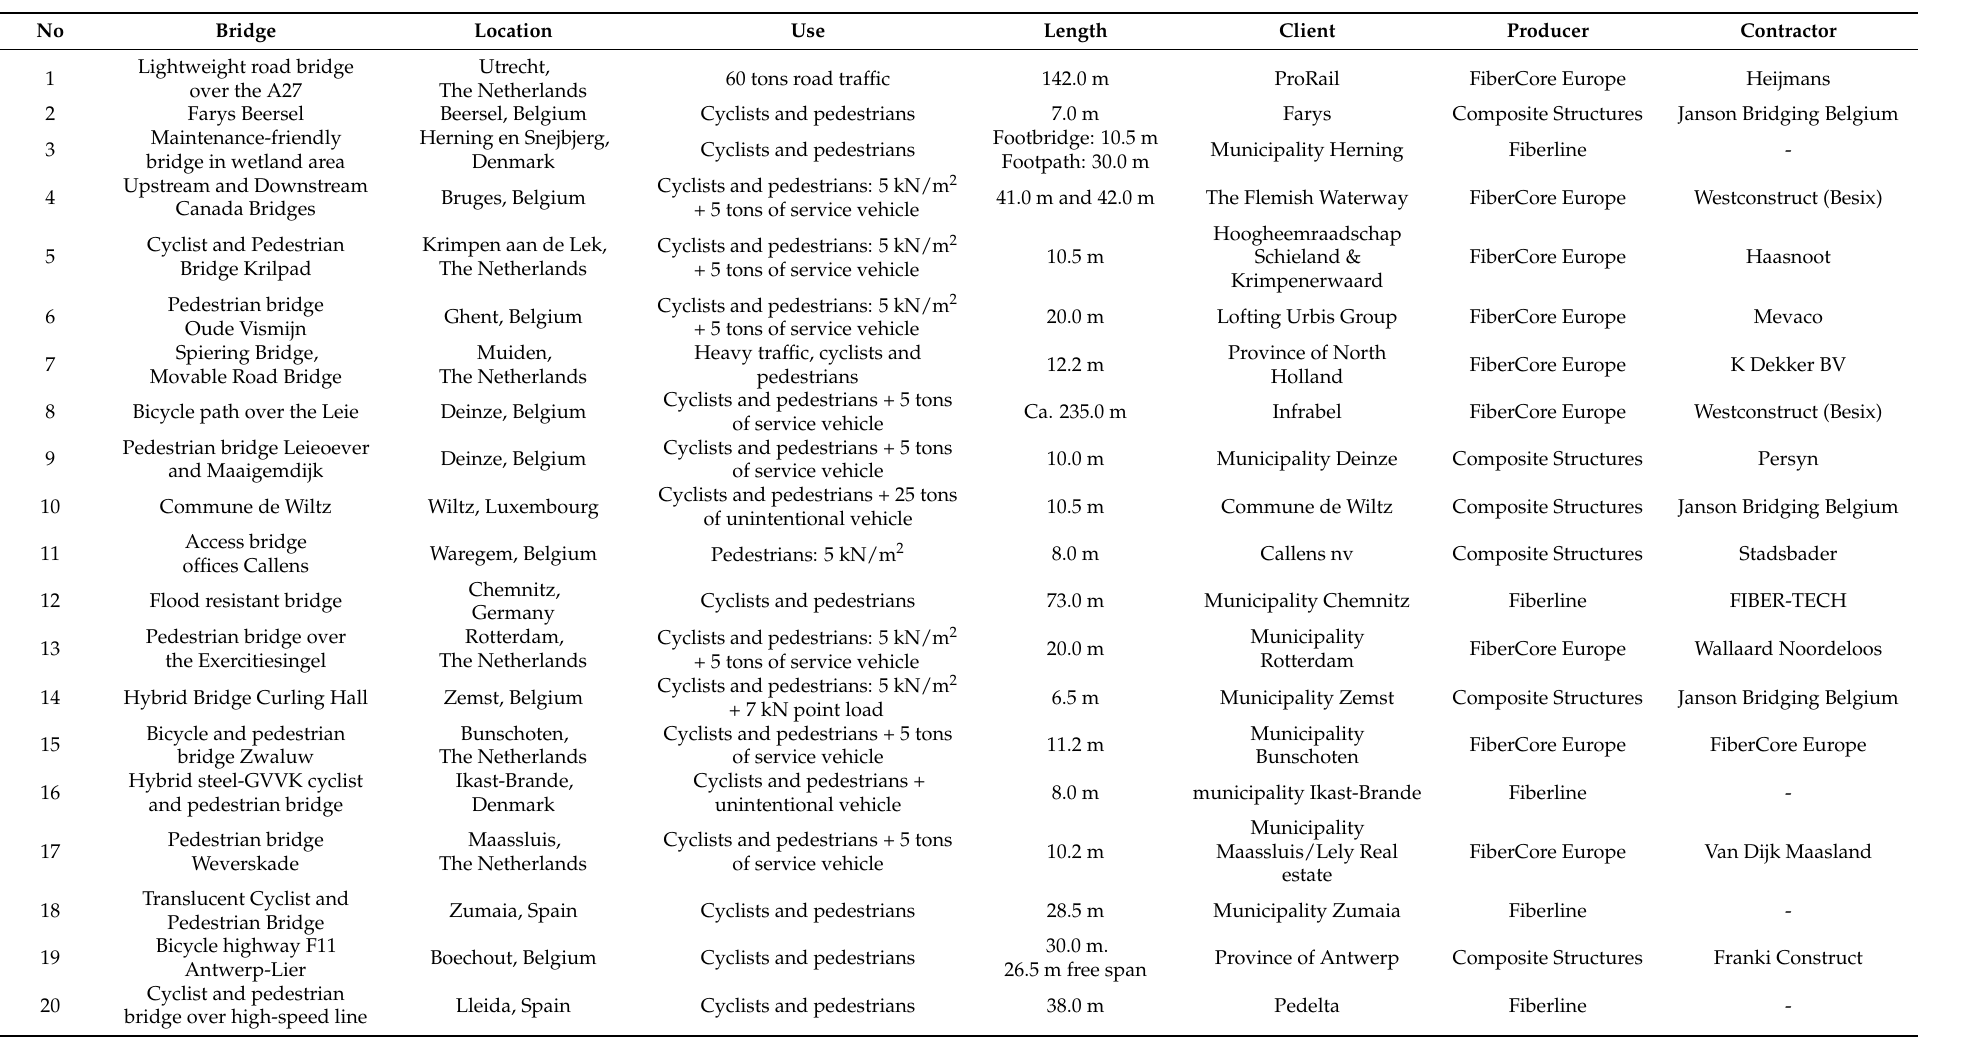
Table 1. Technical data of indicative examples of composite bridges in